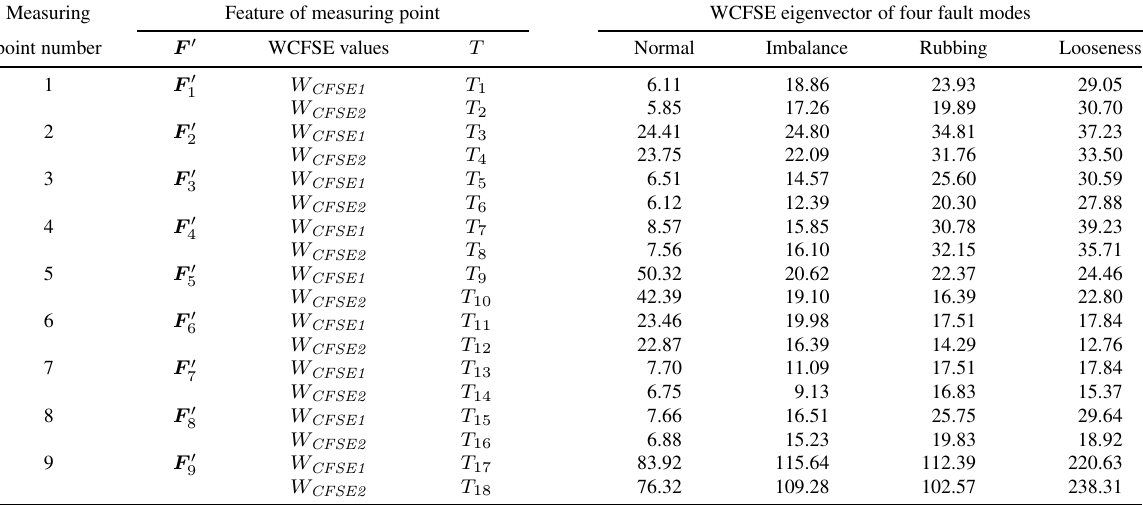
Table 2 Part feature vectors based on WCFSE values under different models